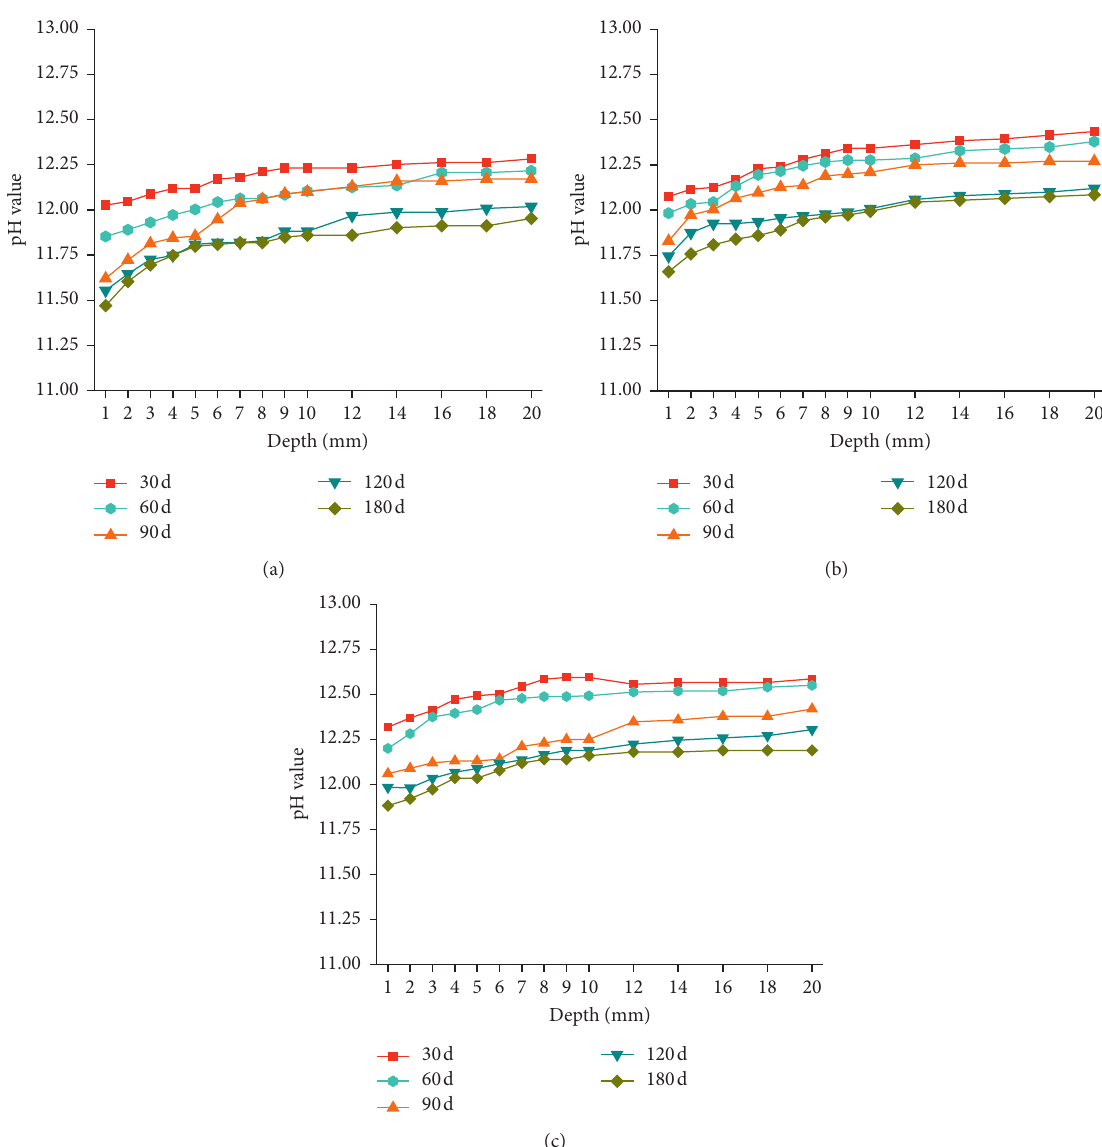
Figure 4: Pore solution pH of BPFRC with different strength grades. (a) BPC-30-0.1. (b) BC-40-0.1. (c)